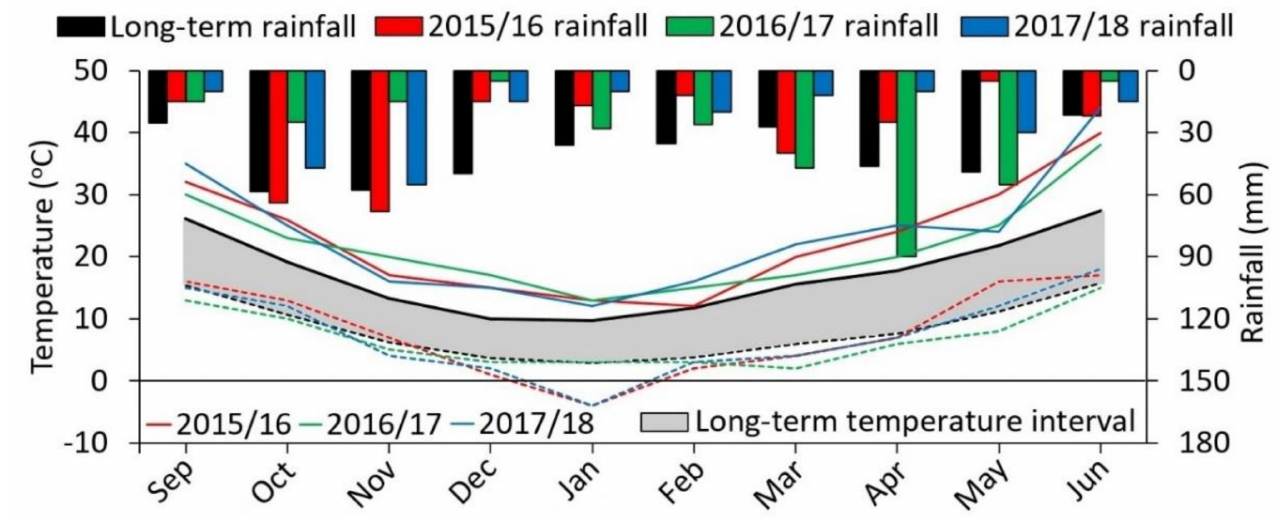
Figure 3. Comparison of the climatic data registered in Madrid from 1990 to 2018 and the three studied seasons (2015/16, 2016/17, and 2017/18). For each season, continuous lines represent maximum temperature, and dash lines are the minimum